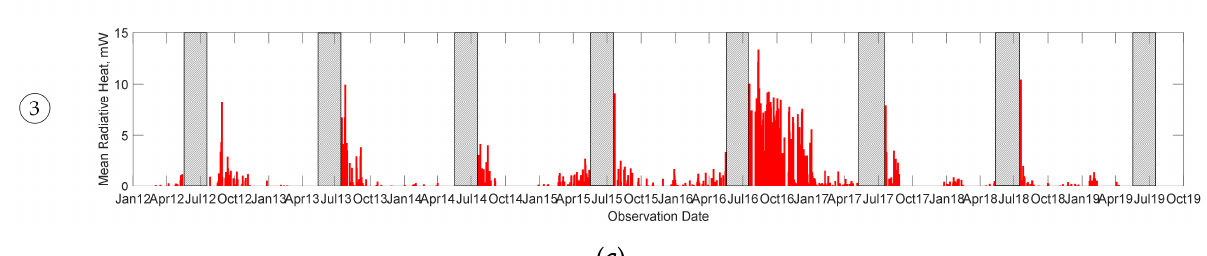
Figure 9. VIIRS Nightfire gas flaring data dashboard for the case study gas processing plant (GPP) in Khanty-Mansi Autonomous Okrug, Russian Federation (62.35° N 74.32° E). ( a ) High-resolution image of the GPP available in Google Earth. ( b ) Recording of fire at the GPP, available from the news outlet. ( c ) VIIRS Nightfire day-to-day dashboard for a field related to the GPP under consideration, including ① spectral radiance in M10 SWIR channel of VIIRS, ② mean estimated temperature of successful detections (in K), and ③ mean estimated radiant heat RH (in MW). Note the shaded area in ③ , which corresponds to summer-time gaps in observations discussed in more detail in Section 4.4.